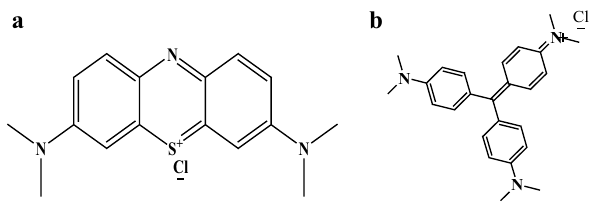
Fig. 1 Structures of the cationic dyes: a methyl blue and b crystal